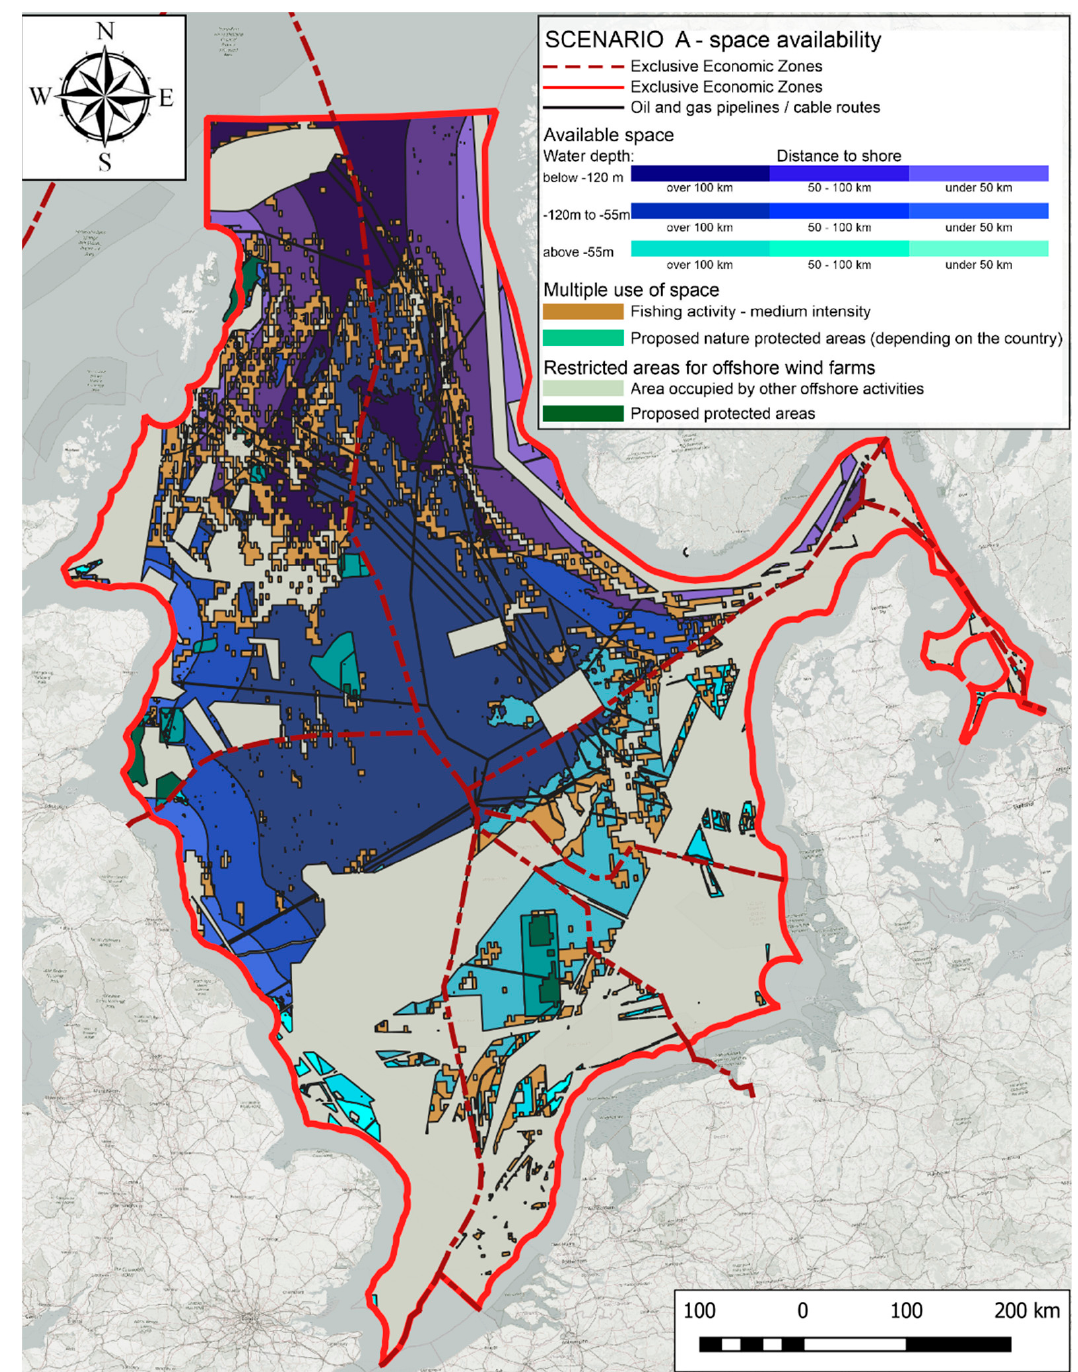
Figure 7. Scenario A: high renewable energy ambitions/integrated planning. Table 7. Available space—Scenario A.